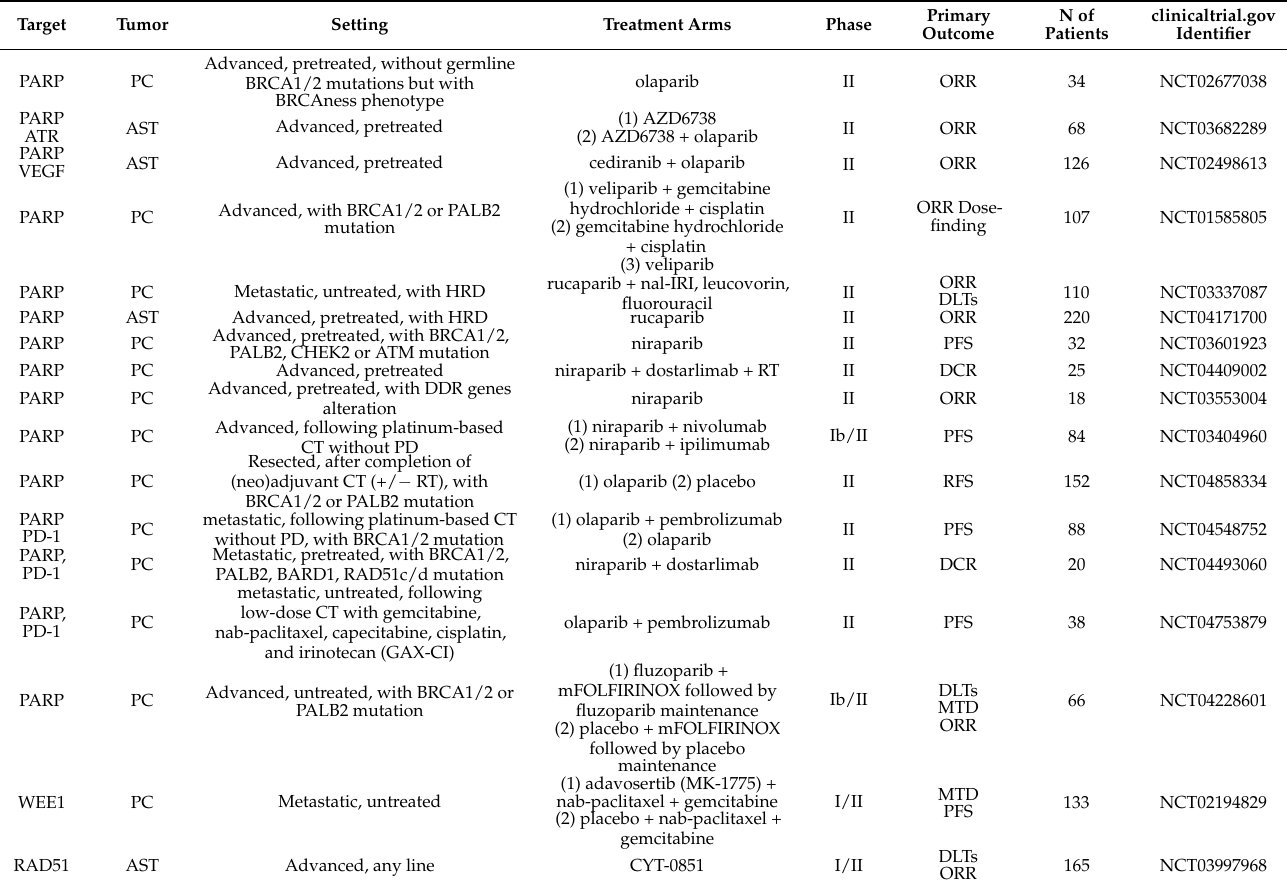
Table 1. Ongoing trials evaluating activity and efficacy of PARP inhibitors in PC (Clinicaltrials.gov last accessed 10 June